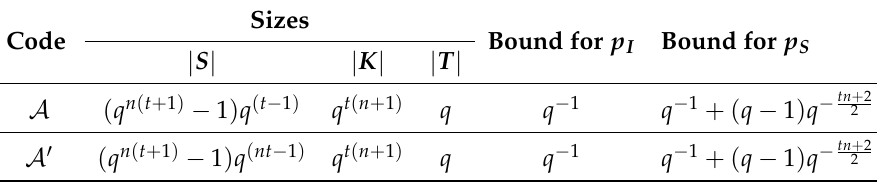
Table 3. Parameters of the obtained systematic authentication code (SAC) A